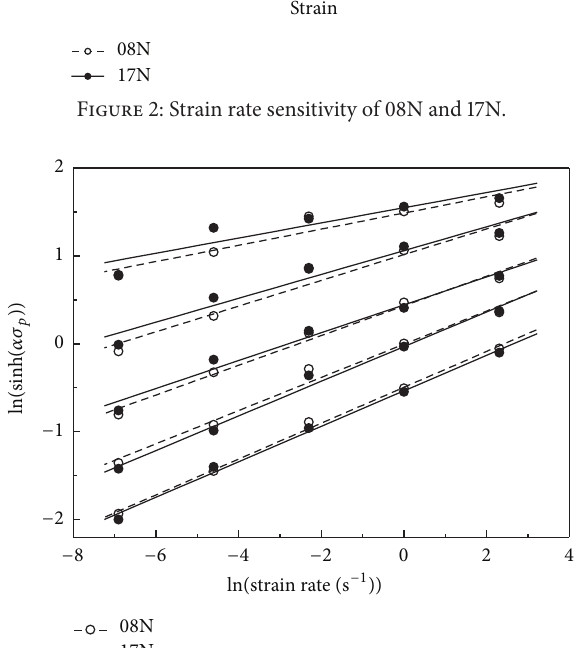
Figure 3: Relationship curves of peak stress with strain rate and deformation temperature for 316LN stainless steels: ln [ sinh (𝛼𝜎)] and ln ̇𝜀 .